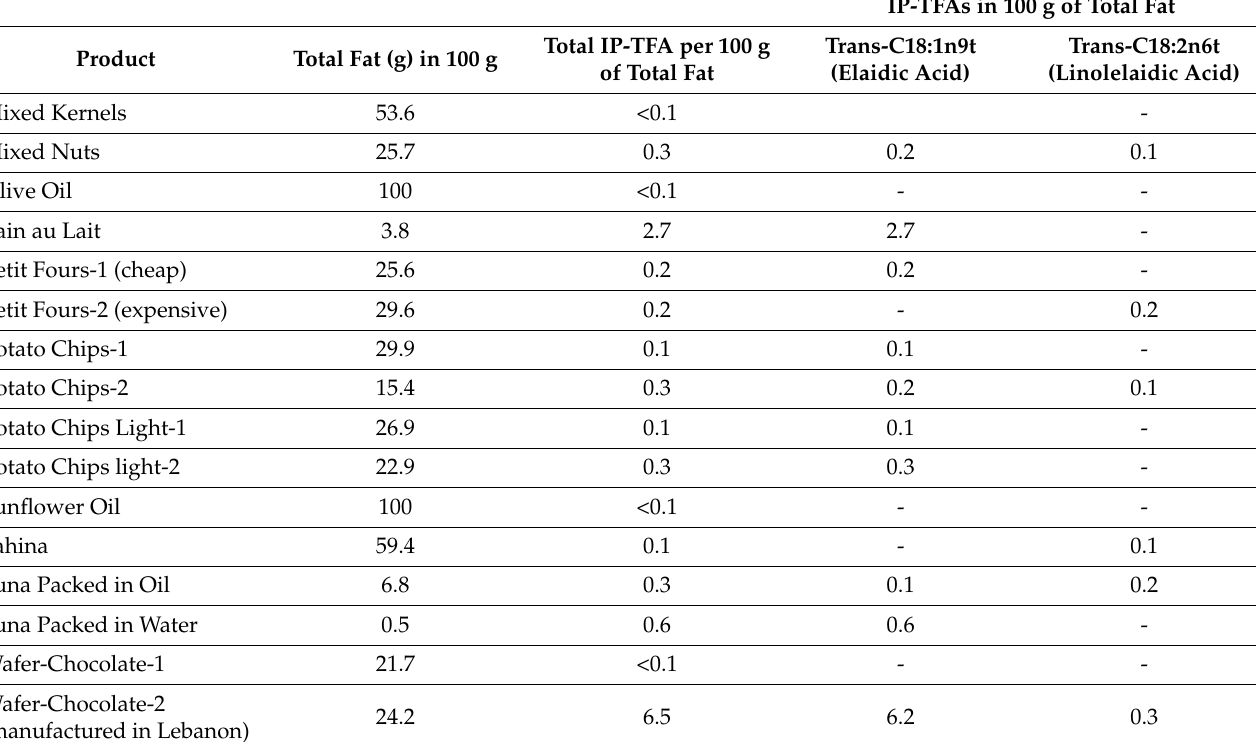
IP-TFAs in 100 g of Total Fat